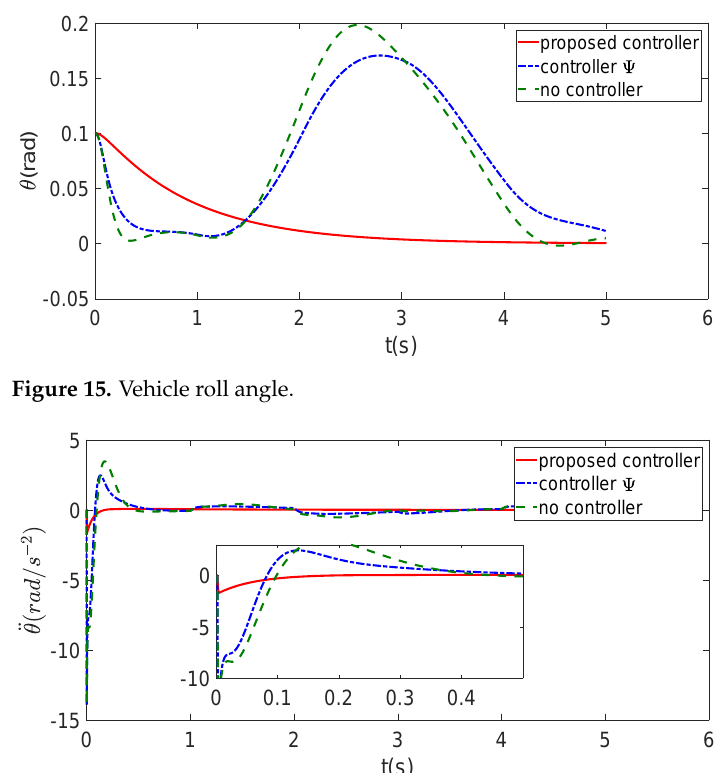
Figure 14. Vehicle body vertical acceleration.